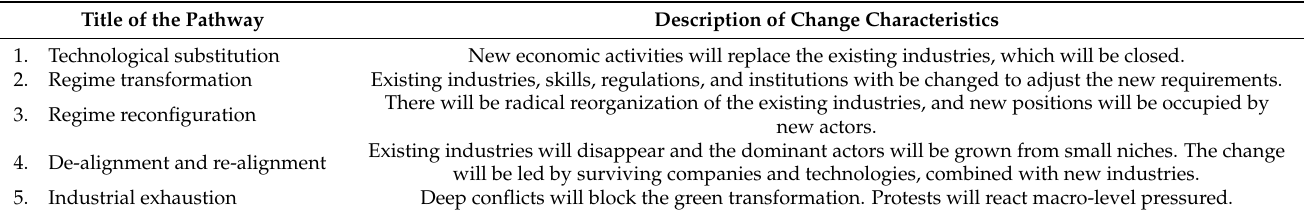
Table 1. Possible pathways towards the green